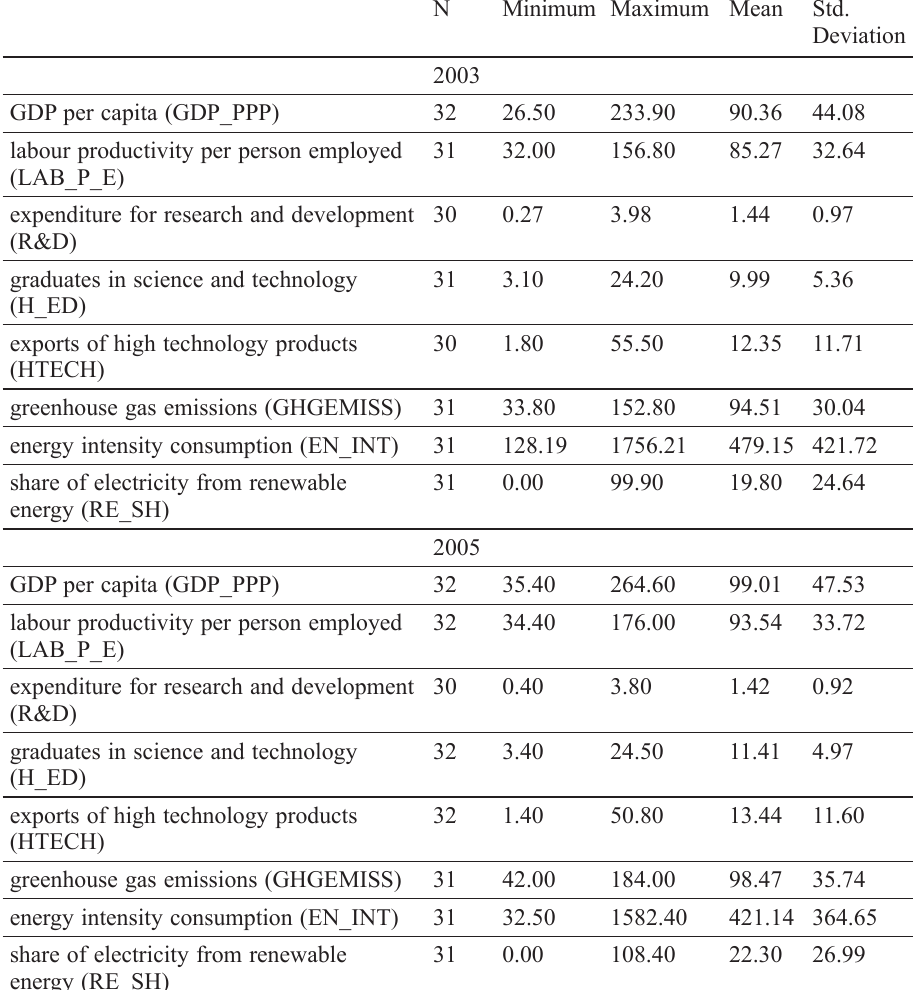
Table 1. Descriptive statistics of the analyzed structural indicators’ variables for the selected 33 European countries in 2003 and